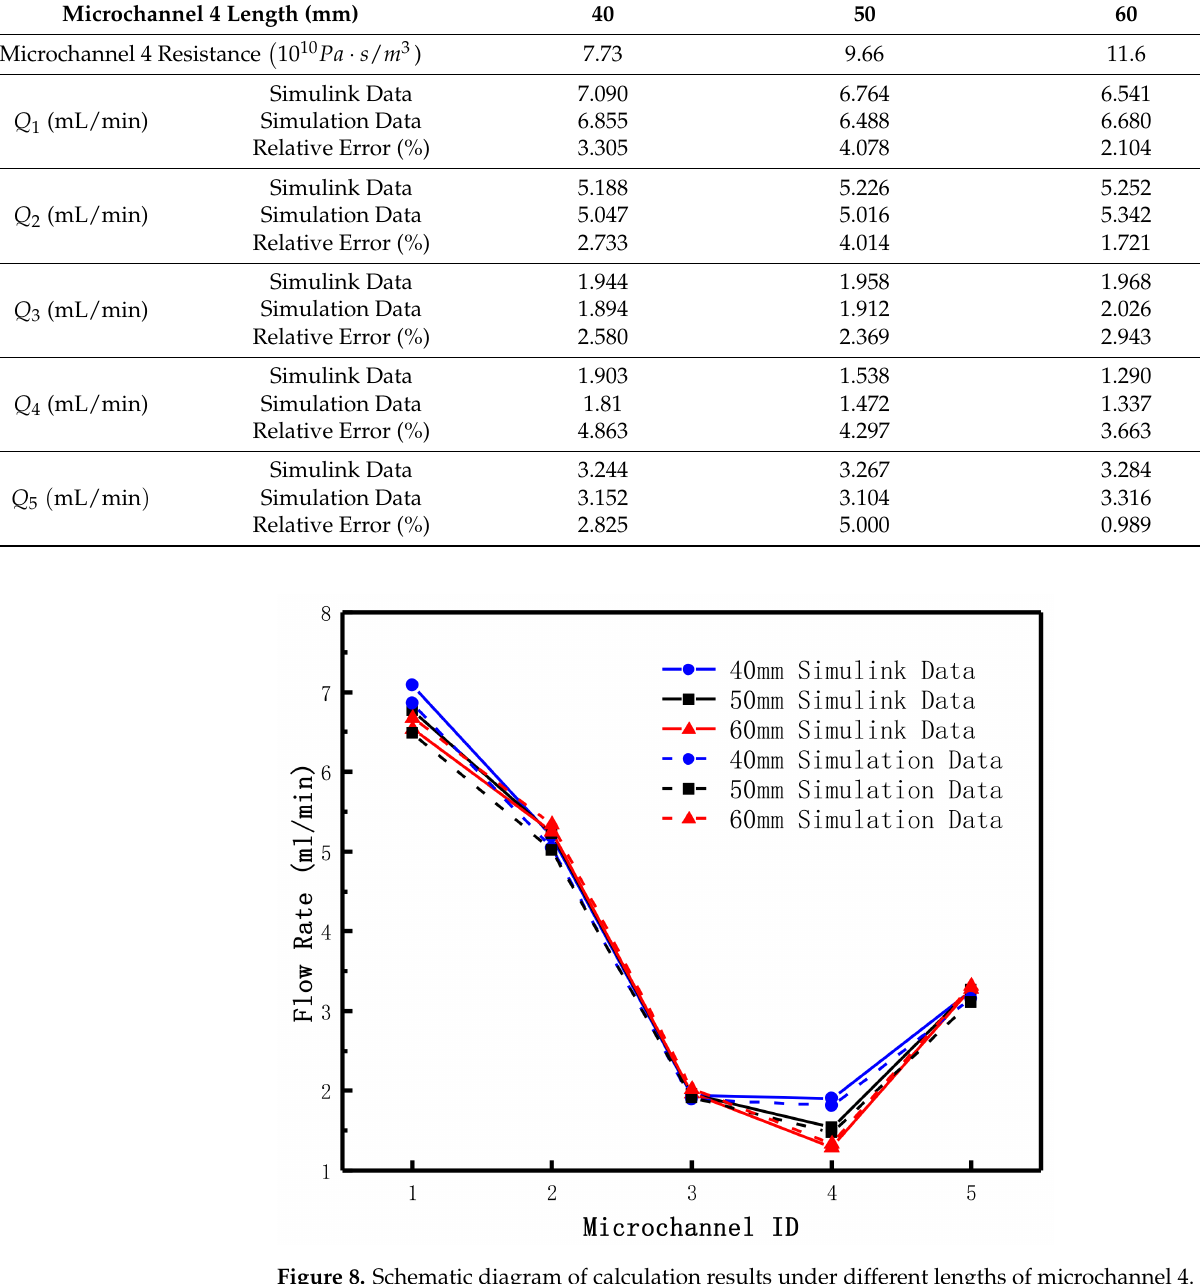
Figure 8. Schematic diagram of calculation results under different lengths of microchannel